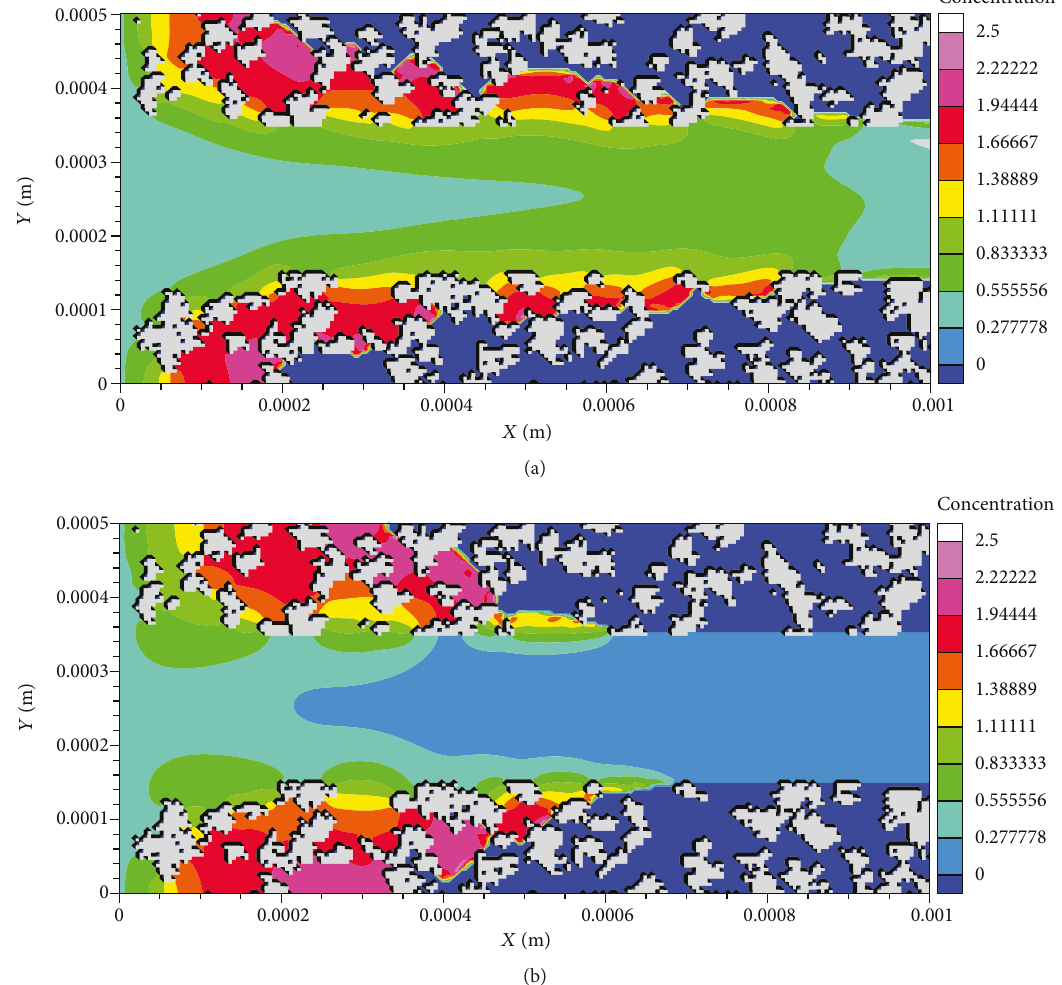
Figure 5: Concentration (mol/L) of species A when (a) Pe =26 and Da =20 and (b) Pe=0.026 and Da =20. In both (a) and (b), porosity (aq) (after dissolution) is near 0.59 but permeability (after dissolution) is 1.60 × 10 − 9 m 2 for (a) and 1.48 × 10 − 9 m 2 for (b). The nonreactive minerals are illustrated in light gray. The areas showing a zero concentration of species A are representing reactive (aq)